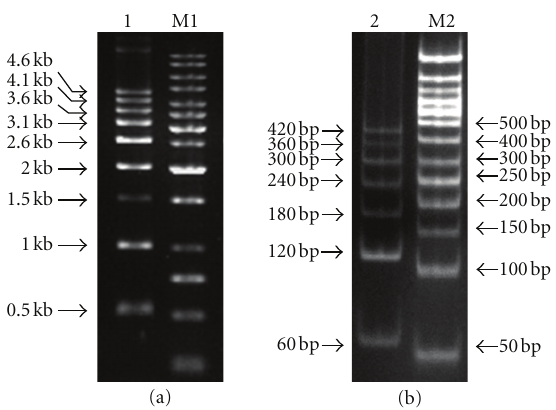
Figure 3: (a) 500 bp DNA ladder on 1% agarose gel (lane 1) and (b) 60bp DNA ladder on 12% acrylamide gel (lane 2) were prepared on the basis of strategy presented in this study. M1: 1kb DNA marker (NEB). M2: 50 bp DNA marker